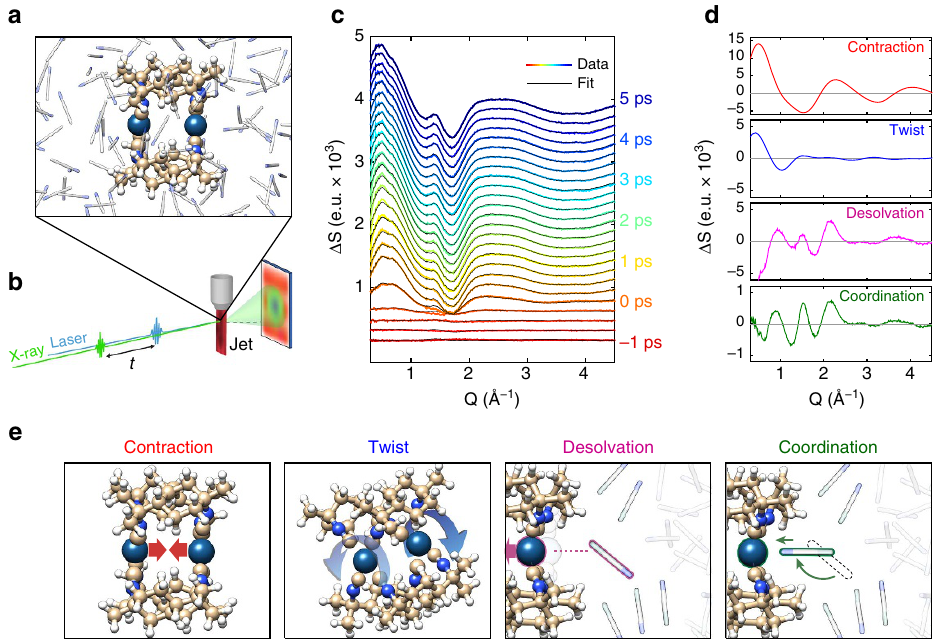
Figure 1 | Scheme and results of the XDS experiments on [Ir 2 (dimen) 4 ] 2 þ . ( a ) Shows a snapshot of [Ir 2 (dimen) 4 ] 2 þ in acetonitrile solution from BOMD simulations. ( b ) Shows the experimental set-up. ( c ) Shows the recorded difference scattering data and fit, each consecutive curve has been offset by 150 e.u. for visibility. ( d ) Shows examples of the four components used to fit the data; The contraction signal is simulated for a 4.2 to 2.9Å contraction of the Ir–Ir distance with no change in the ligand twist. The ligand twist component is simulated for a 0 to 15 (cid:2) degree increase in the N-Ir-Ir-N ligand dihedral twist at an Ir–Ir distance of 2.9Å. The two solute components are extracted directly from the analysis. ( e ) Shows a sketch of four dynamics giving rise to the signals presented in d